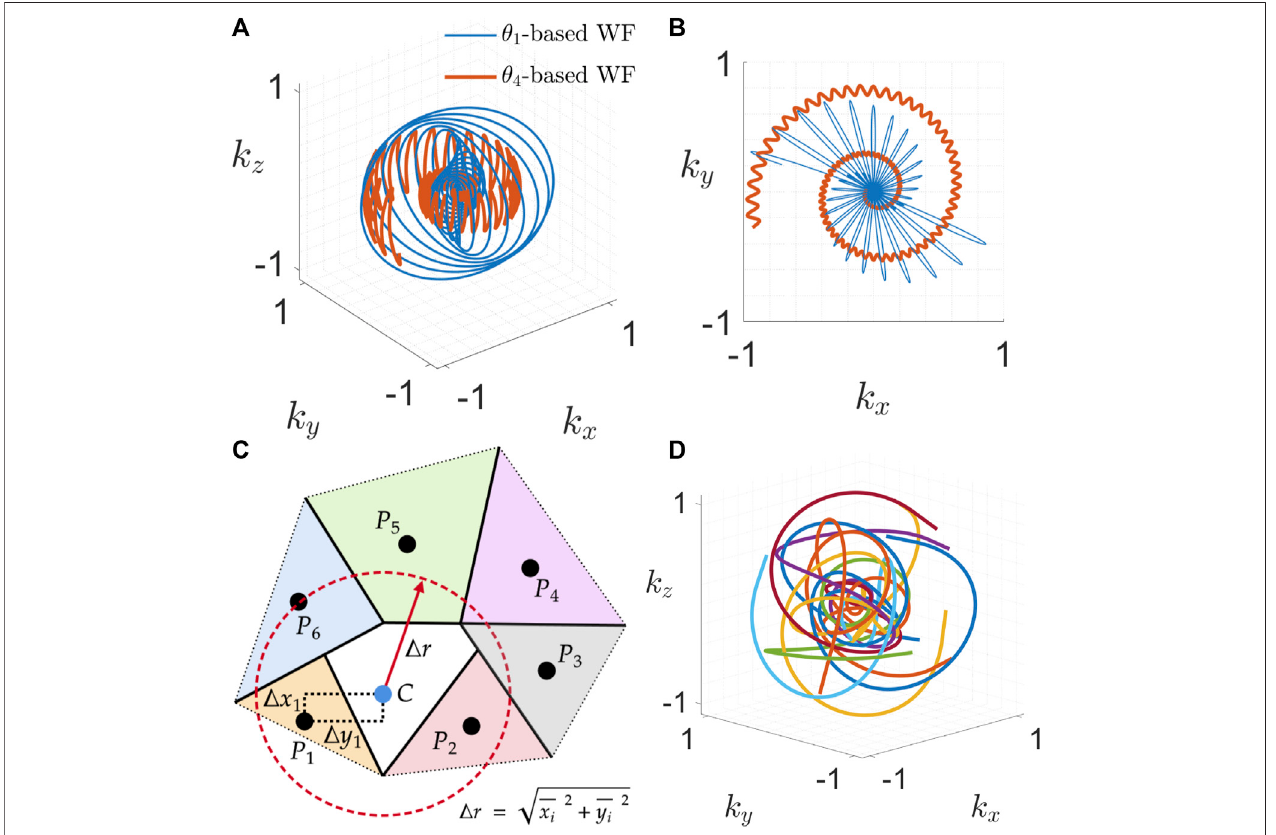
FIGURE1| Twointerleaves,eachbasedonadifferentJacobithetafunction θ 1 and θ 4 .Bothinterleavesareshowninthree-dimensional k -space (A) andasaplaneprojection in (B) . (C) Schematic representation of seven Voronoi cells in a two-dimensional k -space. Six nearest neighbours of the point of interest C are used for the de fi nition of the generalised FOV. (D) Ten interleaves of the presented 3D ζ -based Spiral trajectory. The increased sampling density around the centre of k -space can be clearly appreciated.